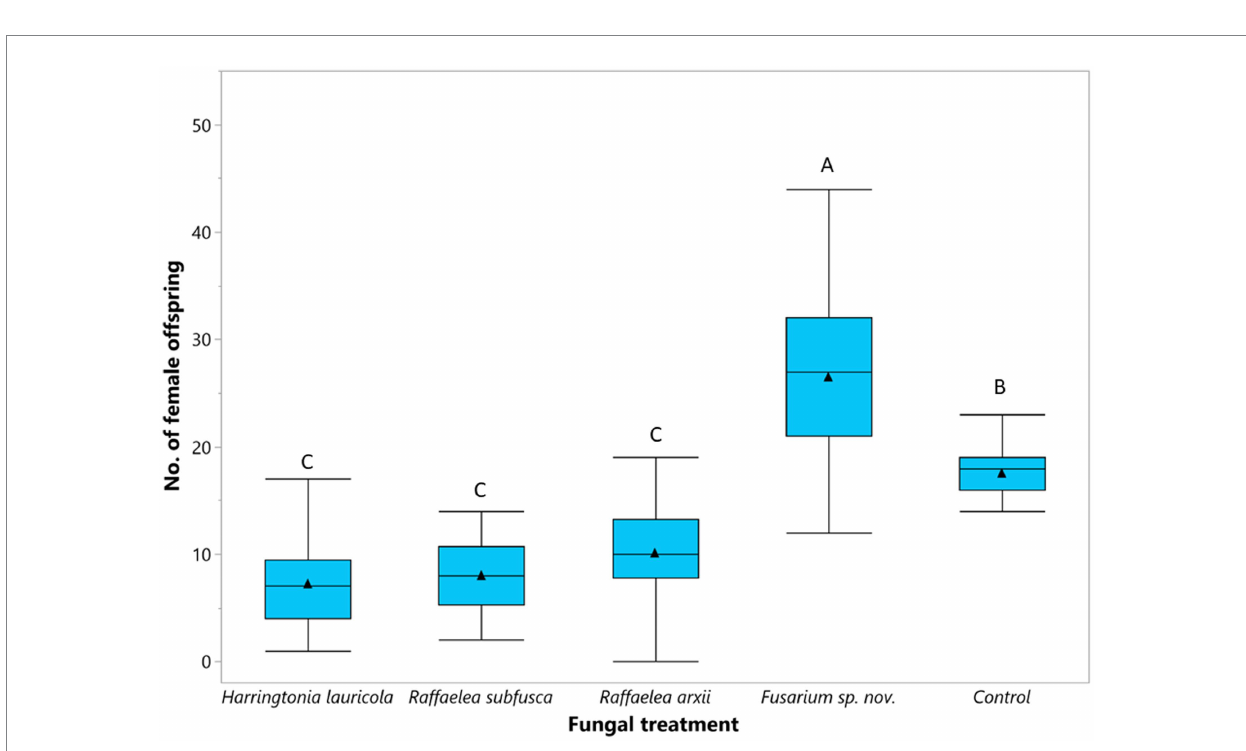
FIGURE 5 Comparison of the mean number of female offspring ( ▲ ) produced by single female founder adapted to single fungal symbiont. Box plots topped with the same letter are not significantly different (Tukey HSD, α =